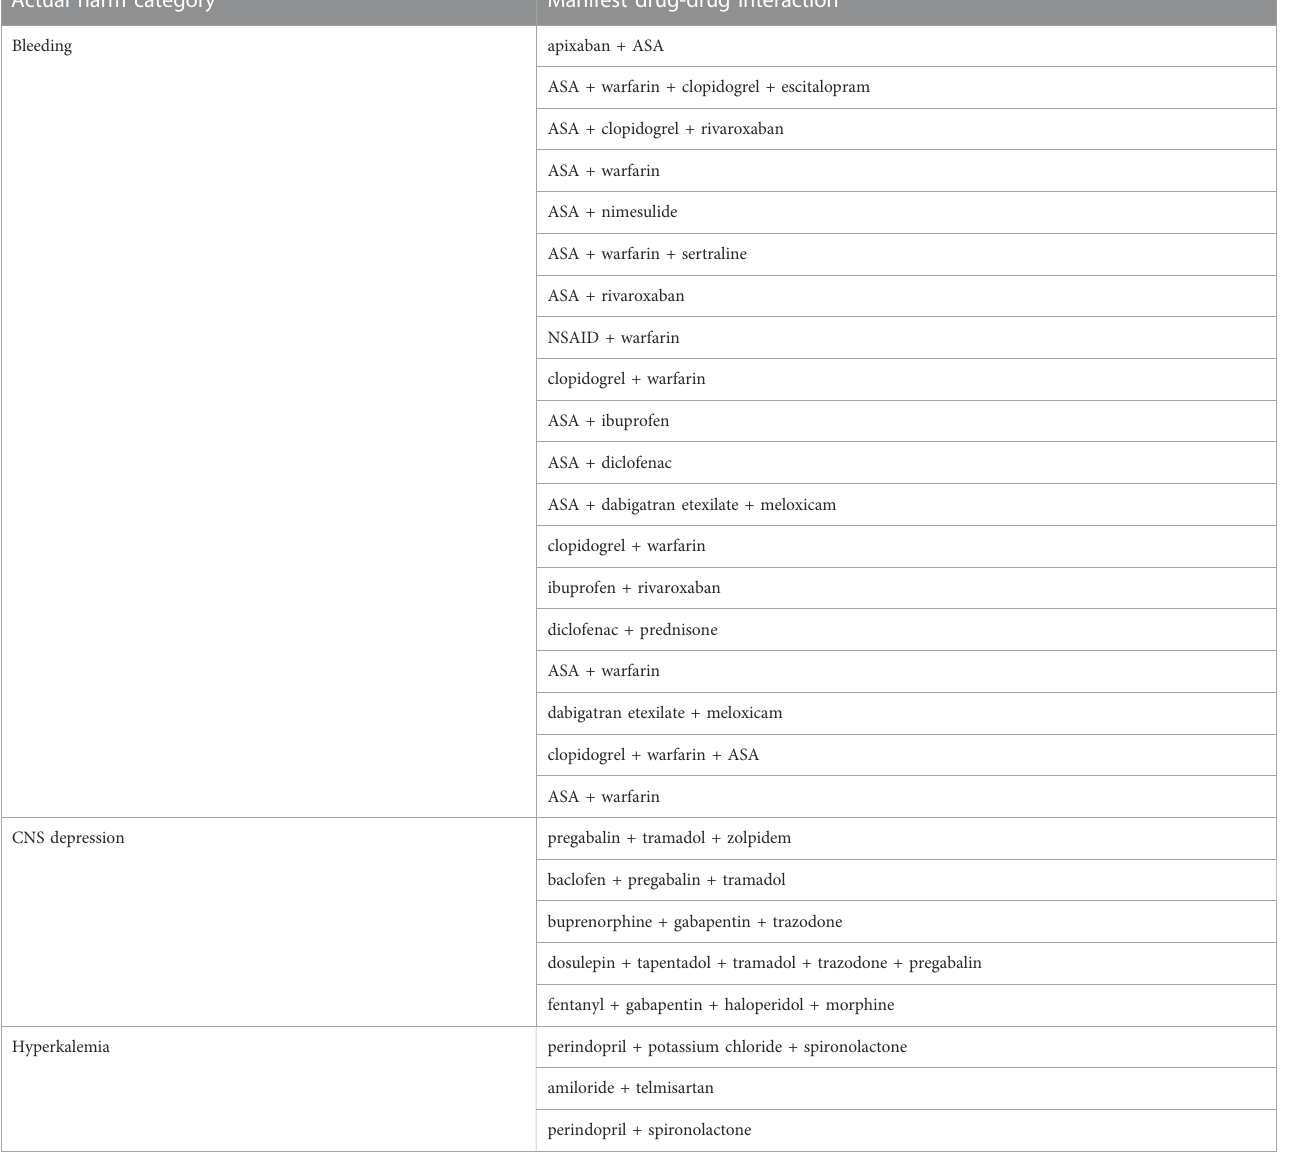
TABLE 3 List of manifest DDIs that were associated with drug-related hospital admissions (n = 27). Actual harm